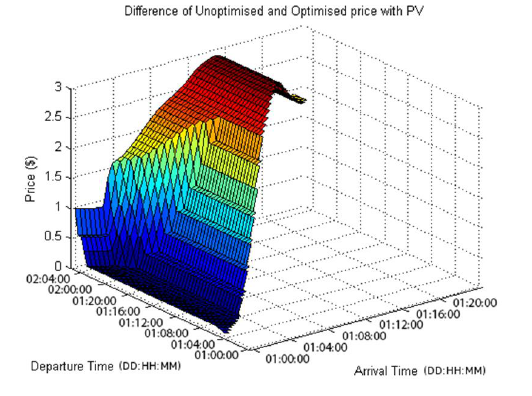
Figure 10: Optimised Charging cost with PV. Figure 11: Difference of non-optimised and optimised price with PV.